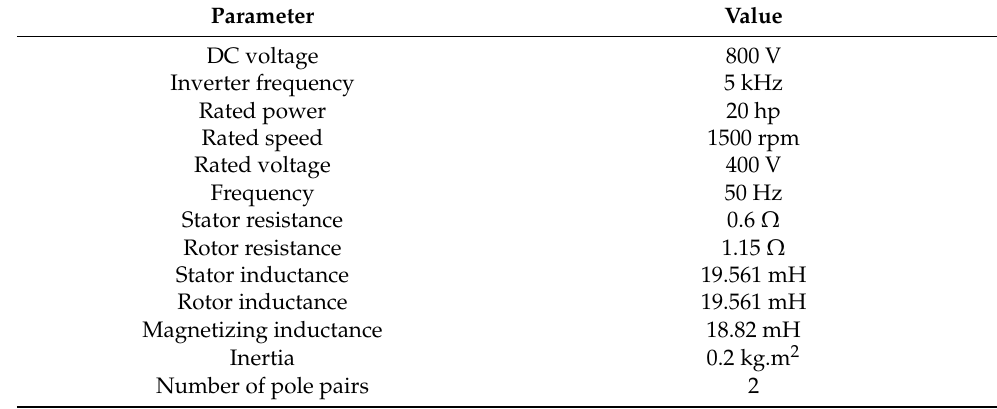
Table A1. Parameters of induction